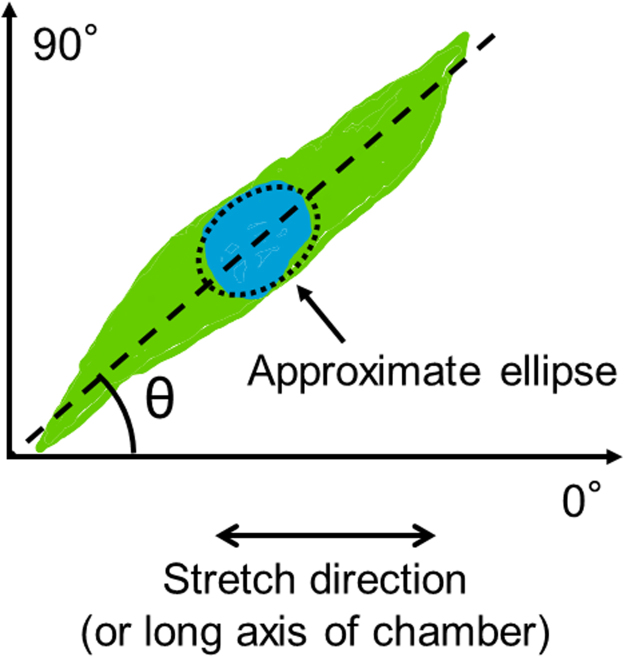
Supplementary Fig. S1. Schematic of how the angle of orientation of the long axis was measured. The angle (θ) is always between 0° and 90° with respect to the stretch direction or long axis of the chamber.